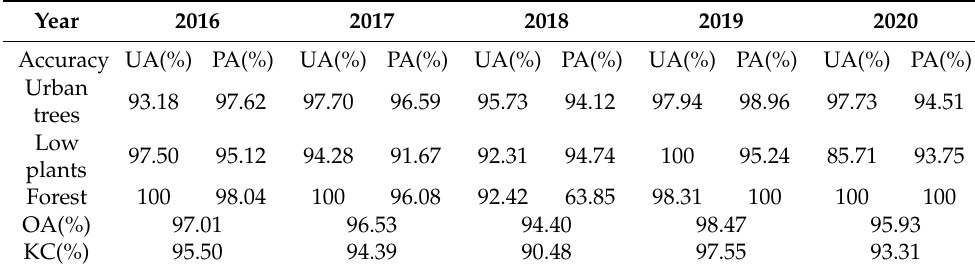
Table 4. Accuracy of annual UGS maps from 2016 to 2020.